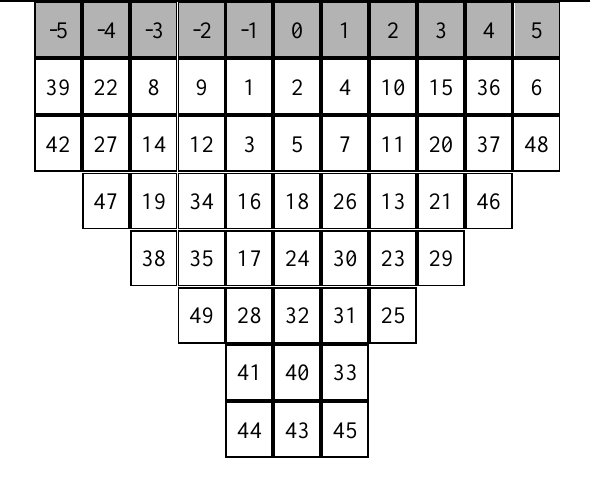
Figure 3: The visual presentation of individual